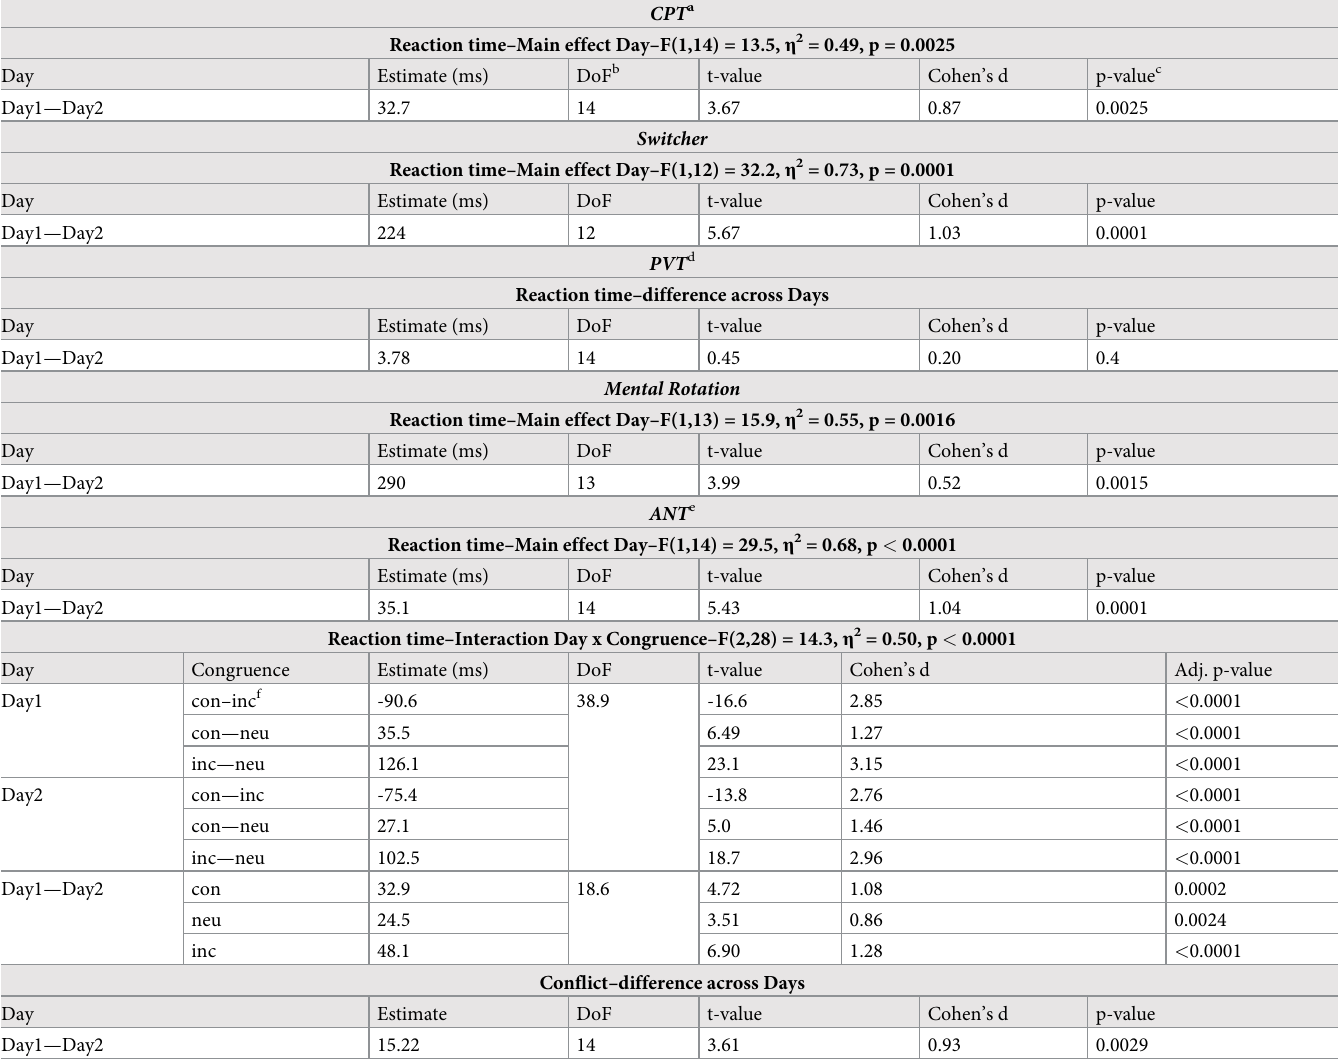
Table 3. Statistics for significant main effects and interactions with the factor Day and subsequent post-hoc